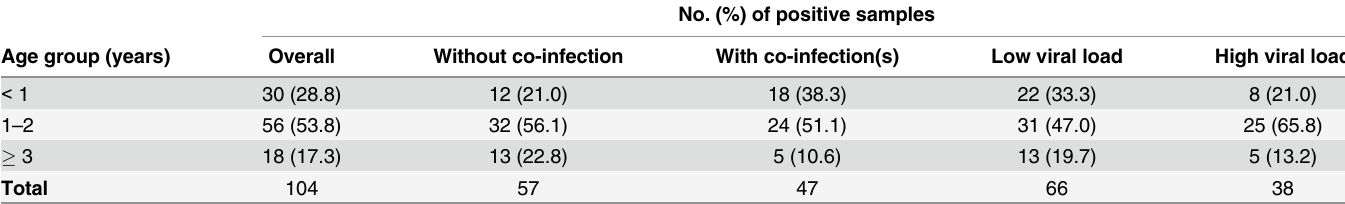
One missing value for